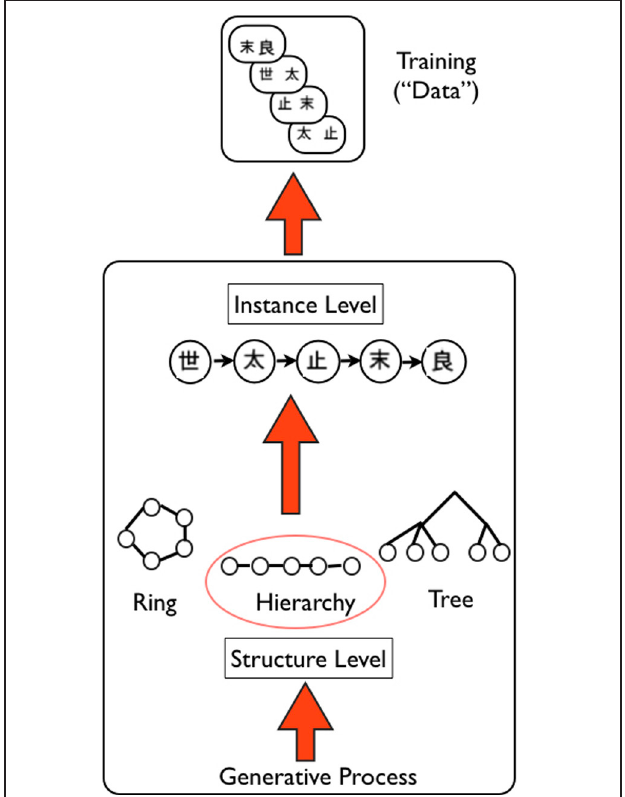
FIGURE 5 | Schematic of Hierarchical Bayesian Model (HBM), as applied to transitive inference task. Overview of the generative HBM of Kemp and Tenenbaum (2008): the model is specified at two levels: a high “structure” level that specifies the type of structure that best explains data—in this case a hierarchy of kanji characters (e.g., used in experiment by Greene et al., 2006)—a generative process based on graph grammars is used to create a library of possible structures. A lower “instance” level specifies the exact version of the structure that is most likely given the data—in this case A > B > C > D > E. The model simultaneously finds the best structure and instance that likely accounts for the data. Upward arrows indicate the generative nature of the